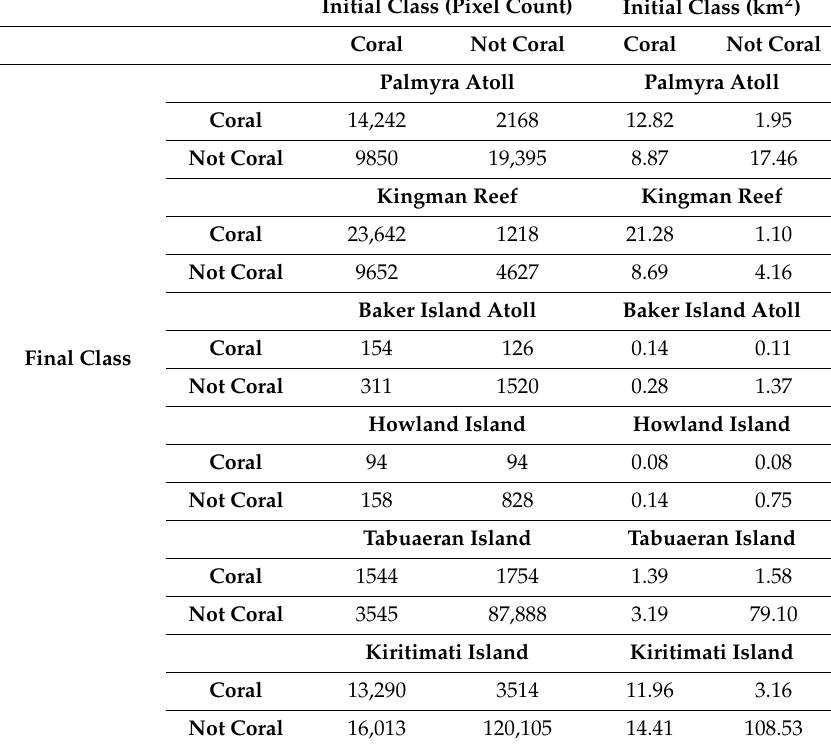
Table 6. Change Detection Analysis by